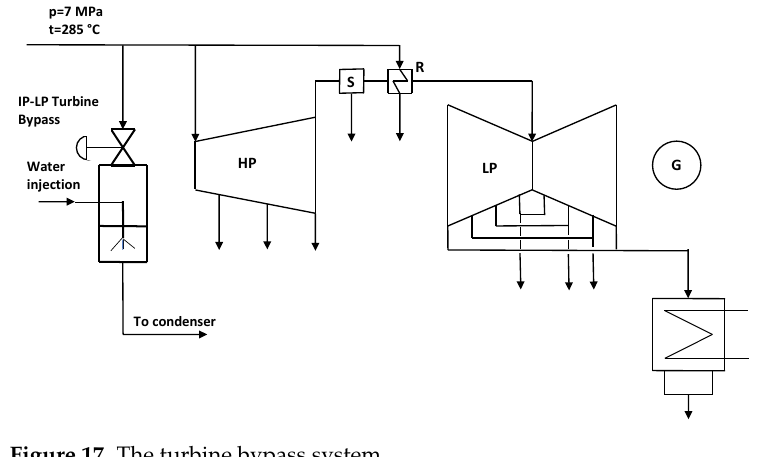
Figure 17. The turbine bypass system.